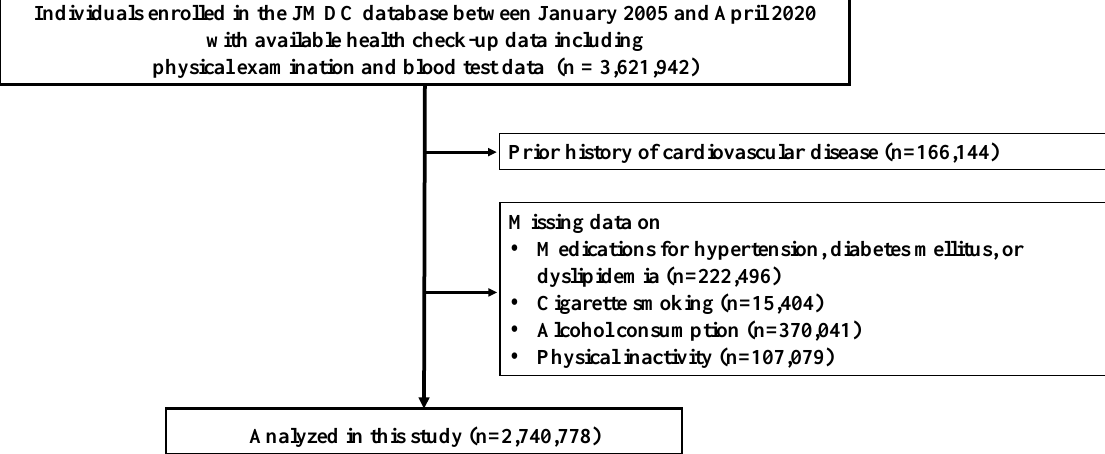
Figure 1. Flowchart. We extracted 3,621,942 individuals with available health check-up data including physical examination and blood test from the JMDC Claims Database between January 2005 and April 2020. We excluded individuals with CVD history of myocardial infarction, angina pectoris, stroke, heart failure, and atrial fibrillation or hemodialysis (n = 166,144), and those having missing data on medications for hypertension, diabetes mellitus, or dyslipidemia (n = 222,496), cigarette smoking (n = 15,404), alcohol consumption (n = 370,041), and physical inactivity (n = 107,079). Finally, we included 2,740,778 participants in this